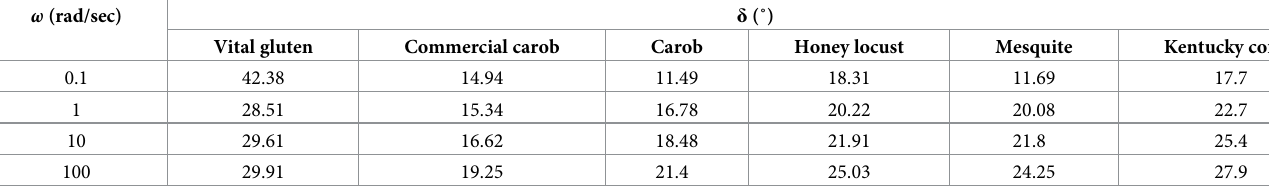
Table 3. Phase angle ( δ ) values obtained at certain frequencies for the protein dispersions. ω